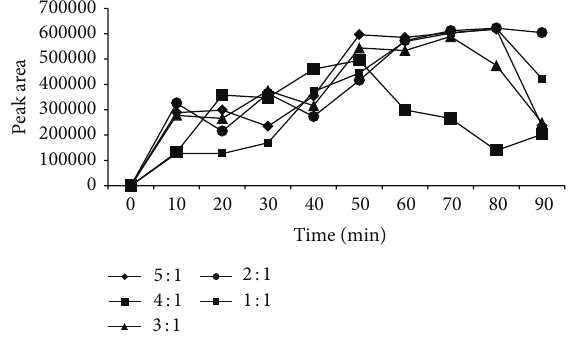
Figure 3: Effects of DBD-COCl and memantine ratios and time on the memantine fluorescent derivative